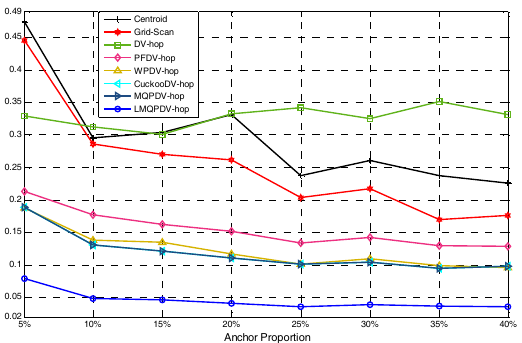
Figure 13. Communication range 250 for WSN#1.